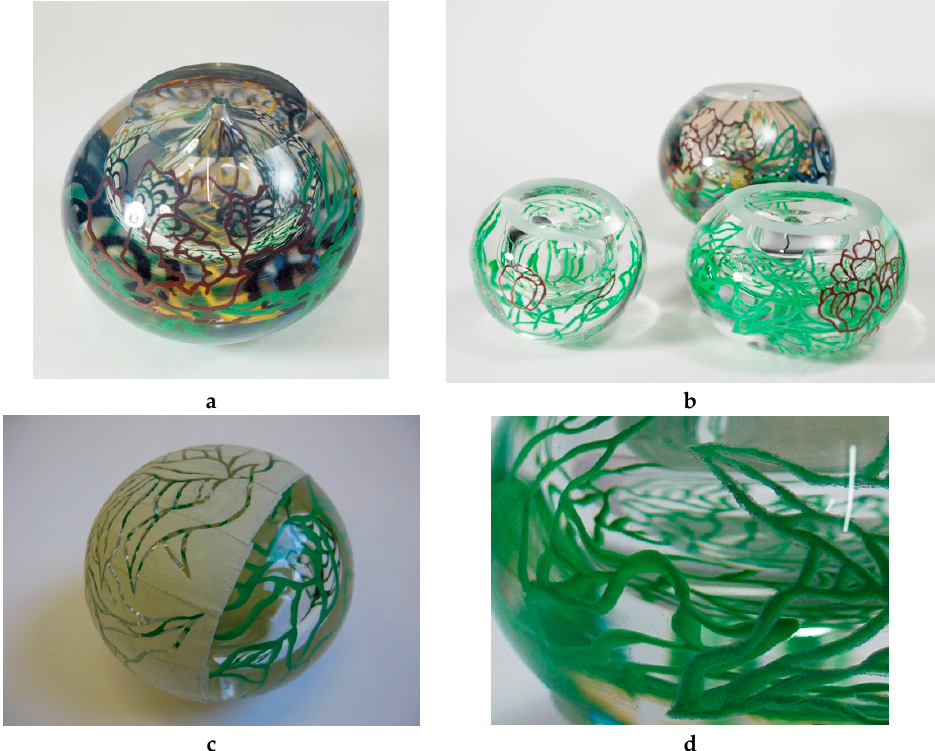
Figure 16. ( a ) ‘ Japanese tattoo pattern ’ test (2012). Cristalica glass body with Kugler glass powder: opaque green (K2070-Opal green), opaque yellow (K2078-Canary yellow), opaque red (K2124-Poppy red), opaque blue (K2091-Lapis blue) and opaque black (K2095-Opal black), 160 mm (H) × 135 mm (W). Two layers of pattern. ( b ) ‘ Tulip pattern ’ tests 1 and 2 (2012). Cristalica glass body with Kugler glass powder: opaque green (K2070-Opal green), opaque yellow (K2078-Canary yellow) and opaque red (K2124-Poppy red). From the left: 1—85 mm (H) × 115 mm (W); 2—130 mm (H) × 140 mm (W). Two layers of pattern. ( c ) Applying the second layer of the design. ( d ) Detail of ‘ Tulip pattern ’ test 2 (2012).